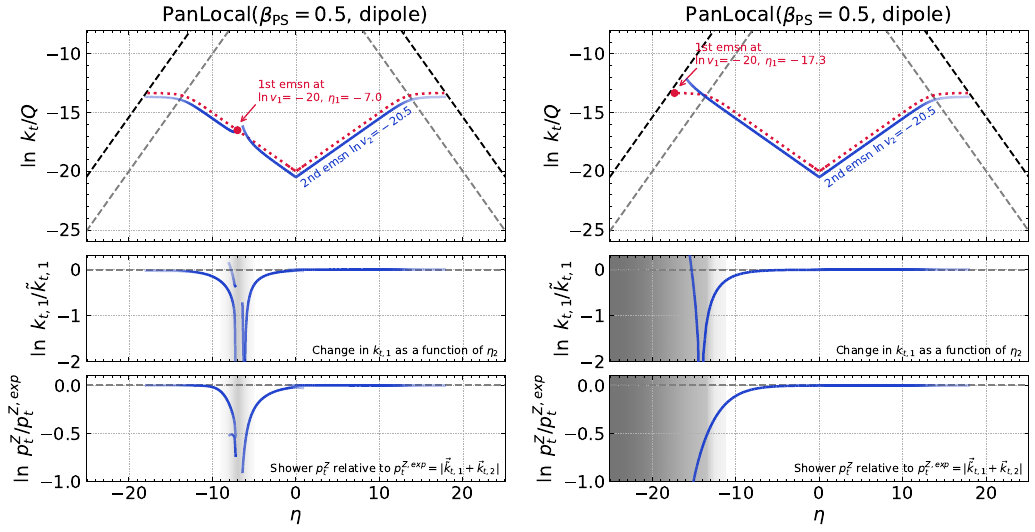
Figure 6. PanLocal contours for two first-emission configurations similar to those of figure 5, but with our default choice of the parameter γ = 1 / (1 + β